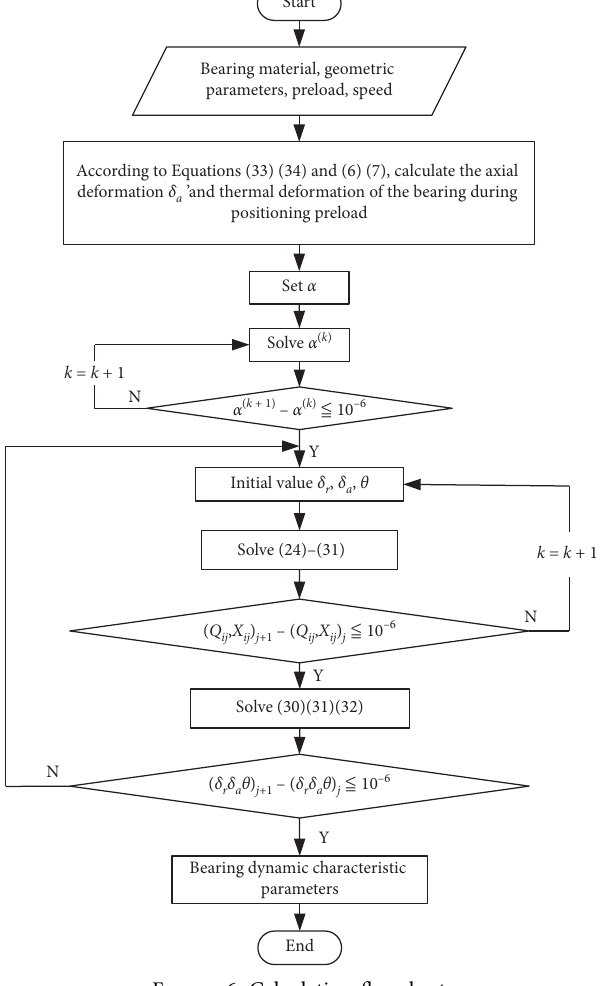
Figure 6: Calculation flowchart.